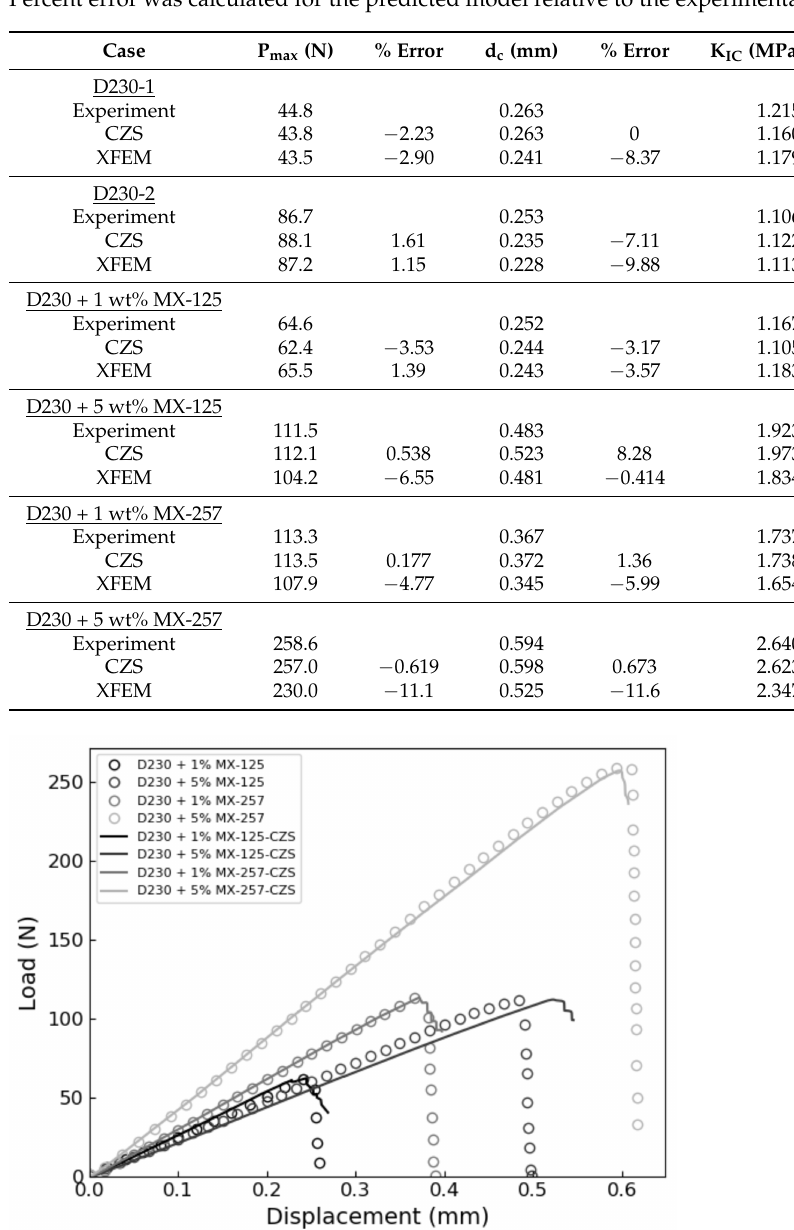
Figure 4. CZS-predicted SENB test load-displacement curves (solid lines) benchmarked against experimental data for each nanocomposite